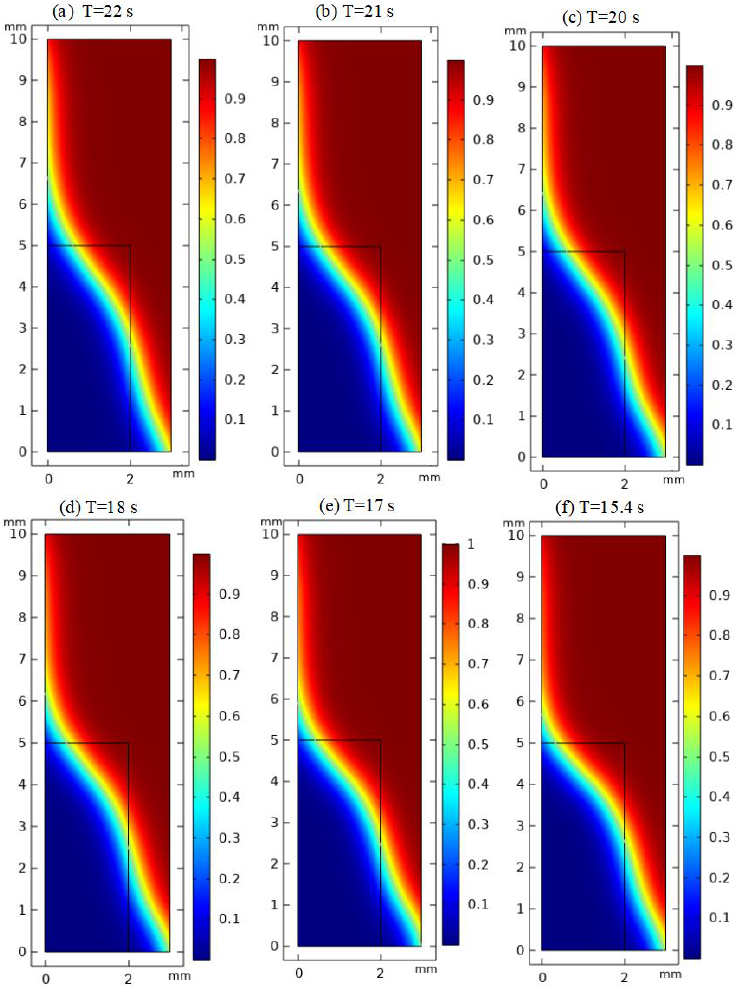
Figure 3. Flow time of hot-melt glass with different viscosity on SiO 2 substrate: ( a ) the viscosity is 1000 Pa·s; ( b ) the viscosity is 900 Pa·s; ( c ) the viscosity is 800 Pa·s; ( d ) the viscosity is 700 Pa·s; ( e ) the 1000 Pa · s; ( b ) the viscosity is 900 Pa · s; ( c ) the viscosity is 800 Pa · s; ( d ) the viscosity is 700 Pa · s; ( e ) the viscosity is 600 Pa·s; ( f ) the viscosity is 500 Pa·s. viscosity is 600 Pa · s; ( f ) the viscosity is 500 Pa · s.